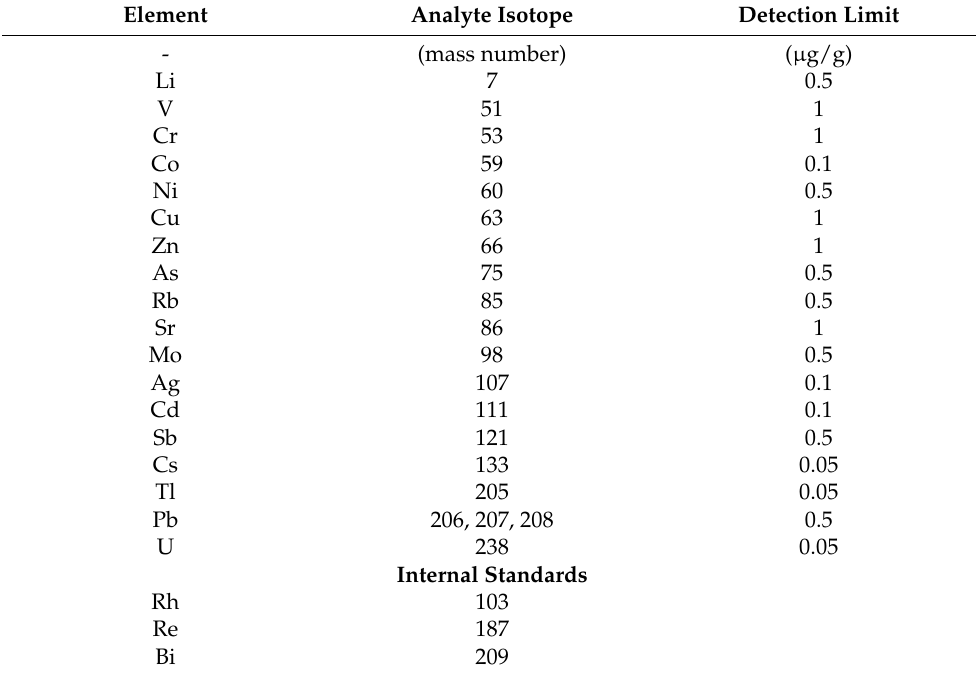
Table 2. Analytical isotopes and detection limits ( µ g/g in the solid sample) for ICP-MS analyses.